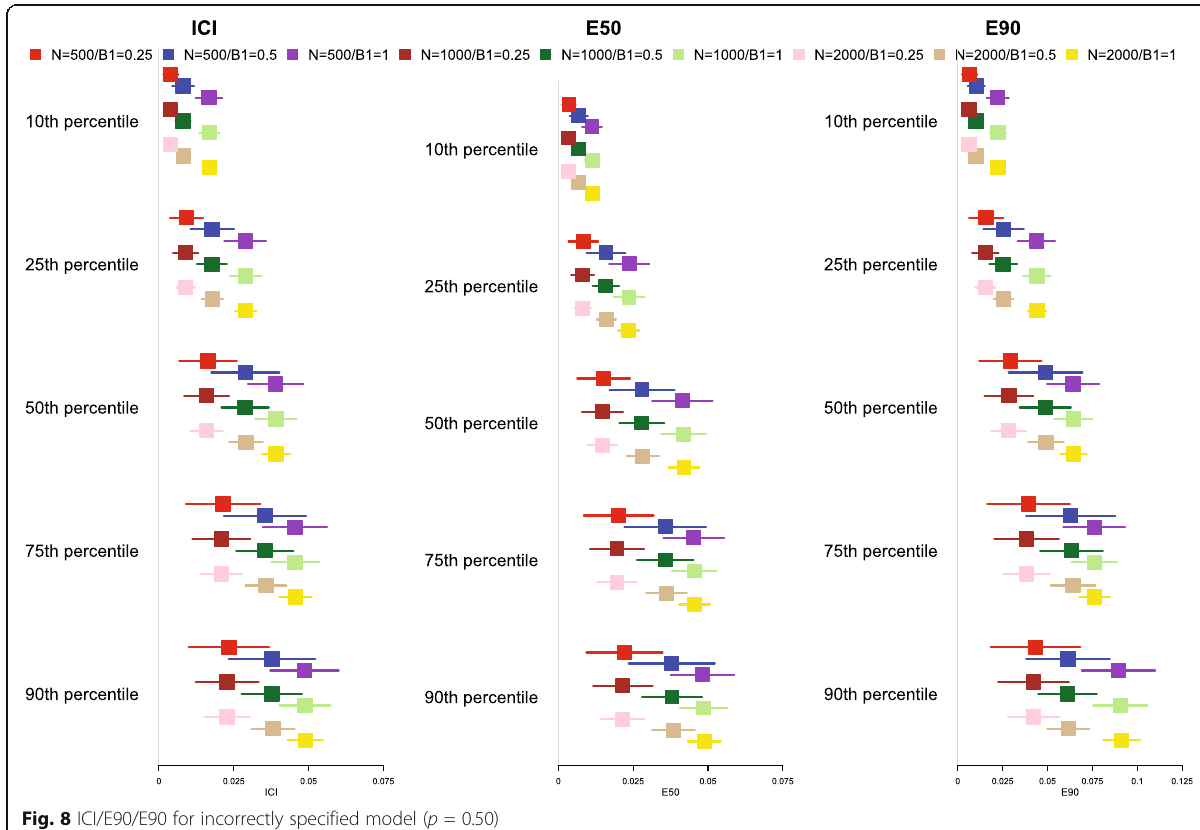
Fig. 8 ICI/E90/E90 for incorrectly specified model ( p =